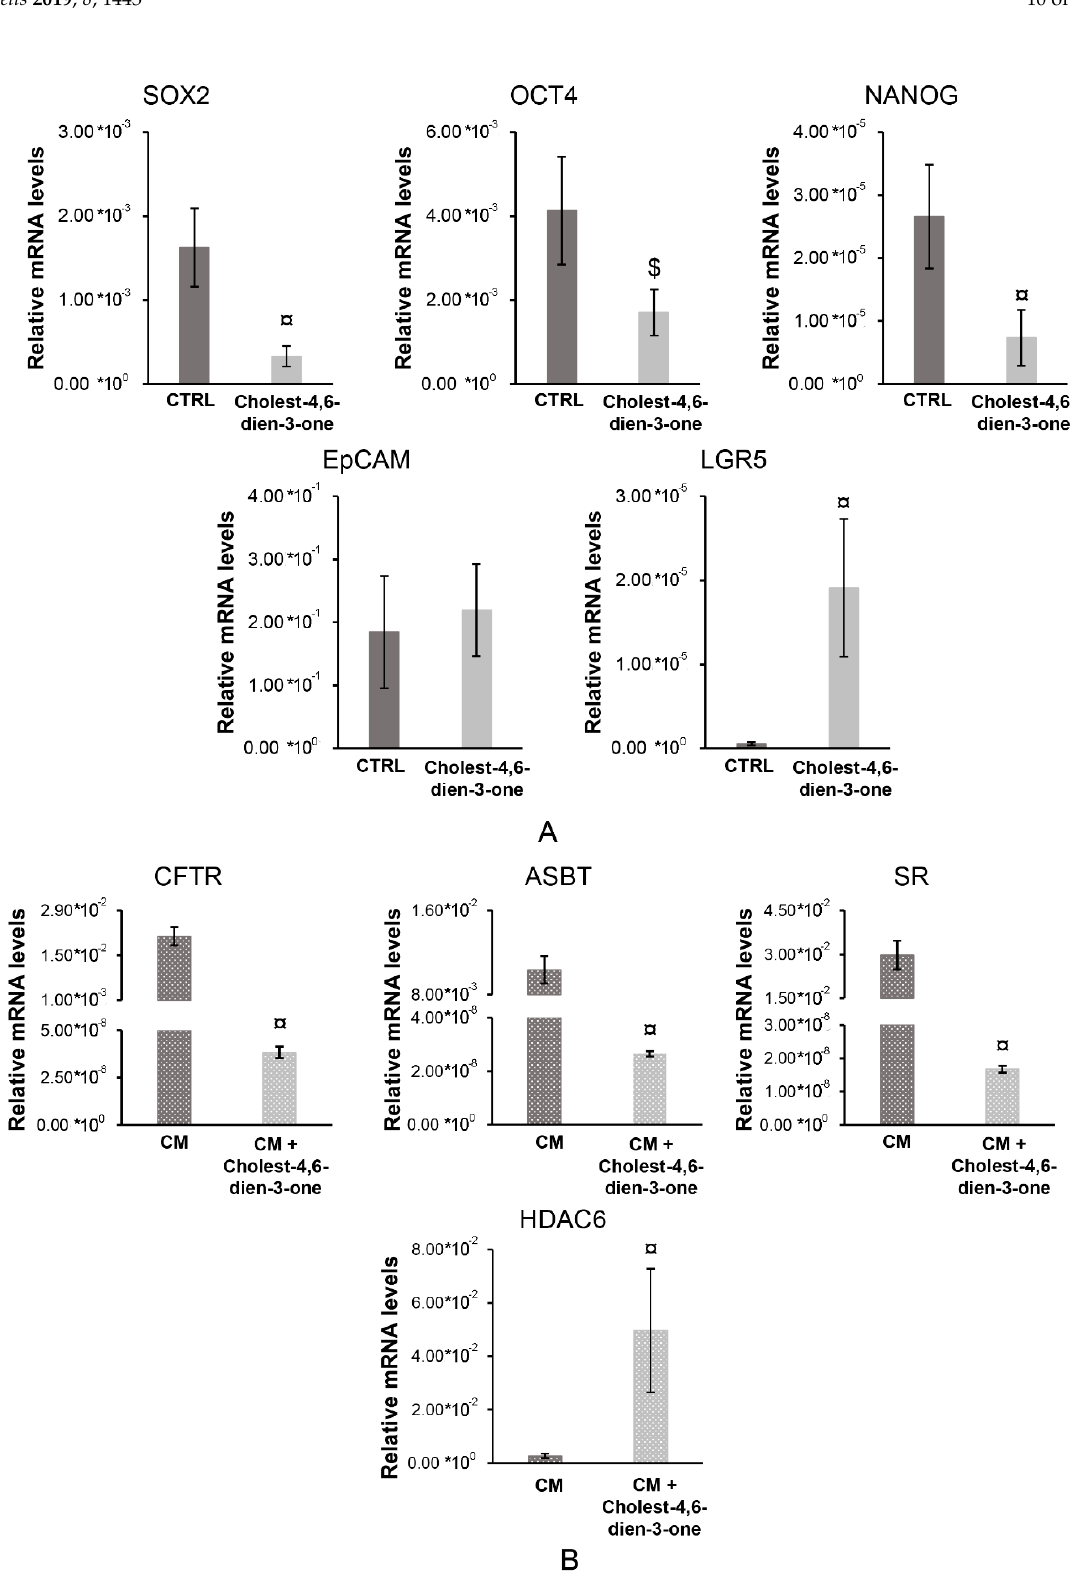
Figure 3. Cholest-4,6-dien-3-one reduced the expression of stem cell markers and blocked the differentiation in mature cholangiocyte. ( A ) Relative gene expression of SOX2 , OCT4 , NANOG , EpCAM , and LGR5 analyzed by RT-qPCR in hBTSCs cultured in KM added with cholest-4,6-dien-3-one or basal condition (KM). (B ) Relative gene expression of CFTR , ASBT , SR , and HDAC6 analyzed by RT-qPCR in hBTSCs cultured in CM added with cholest-4,6-dien-3-one or differentiation medium tailored to mature cholangiocyte (CM). Data expressed as mean ± SD of N = 6 experiments; $ p < 0.001; ¤ p < 0.0001.